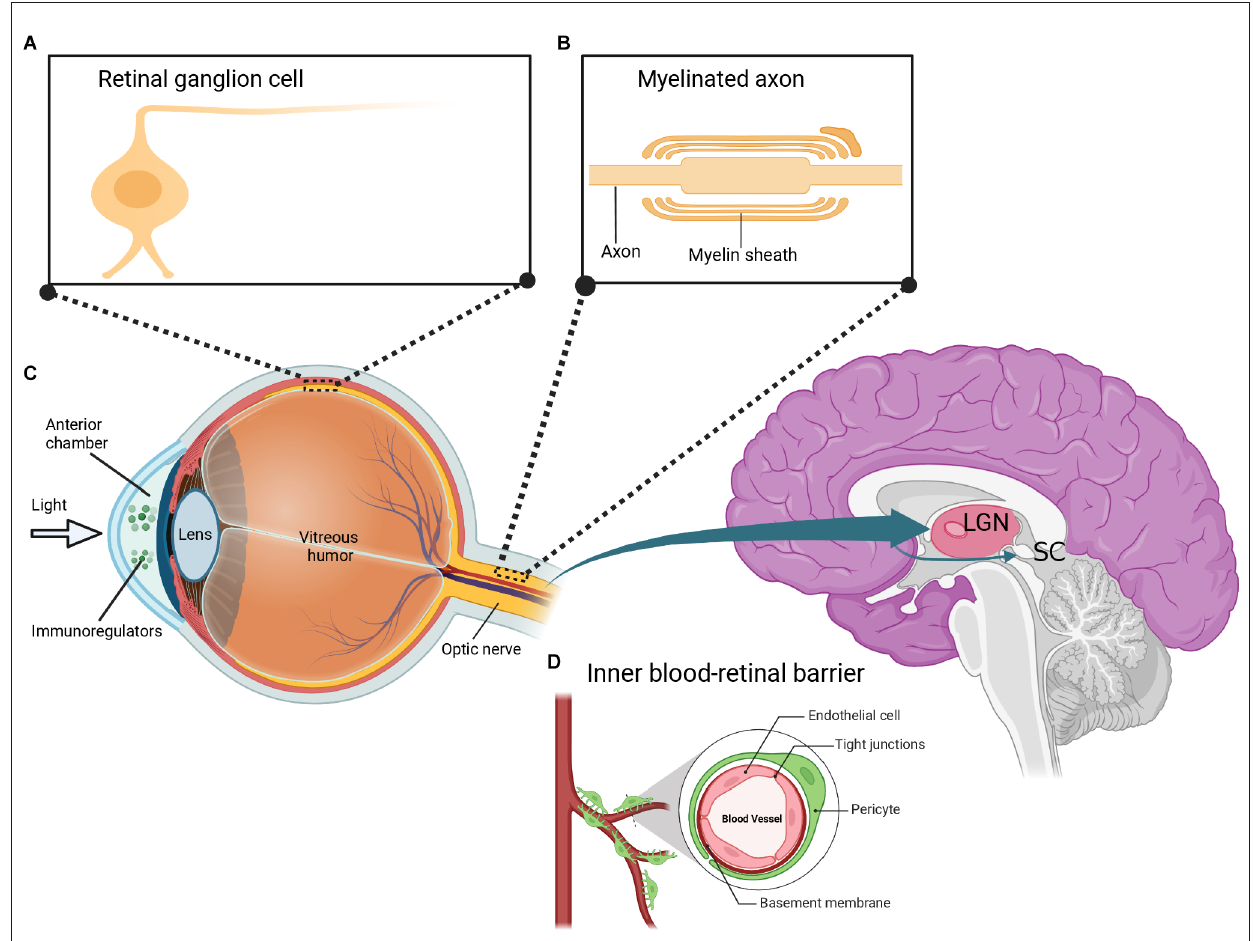
FIGURE2 Depiction of the eye-brain connection. (A) The retina contains several layers of neurons including retinal ganglion cells (RGCs), which are morphologically similar to neurons in the brain. (B) RGCs have myelinated axons that are organized to form the optic nerve. The optic nerve extends to the lateral geniculate nucleus (LGN) and superior colliculus (SC) in the brain. (C) Similar to the brain, the eye is uniquely associated with the immune system and is composed of immunoregulatory molecules. (D) The inner blood-retinal barrier, which is analogous to the blood-brain barrier, further shows the relationship between the eye and the immune system. Created with BioRender.com (accessed December 13, 2022).